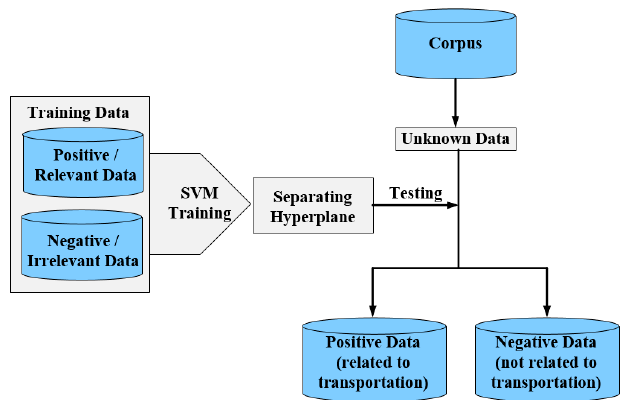
Figure 2. SVM-based data filtering.